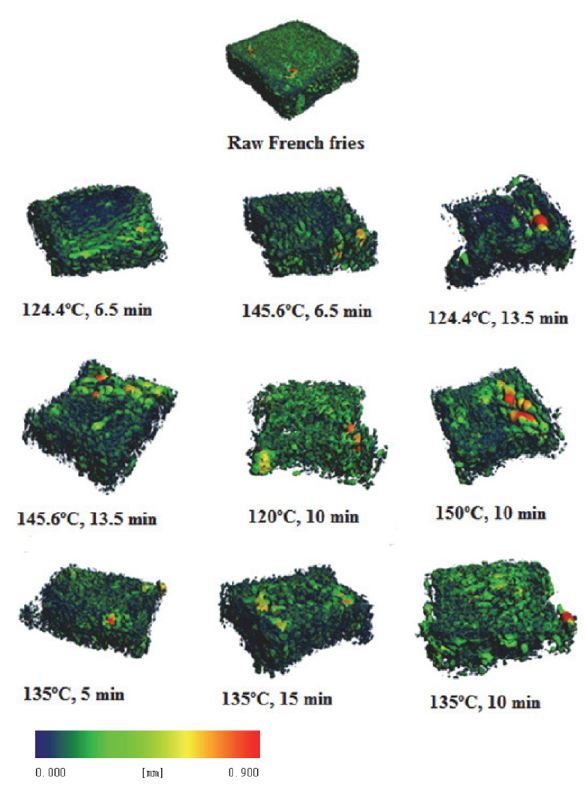
Fig. 3. Micro-CT images of vacuum fried French fries